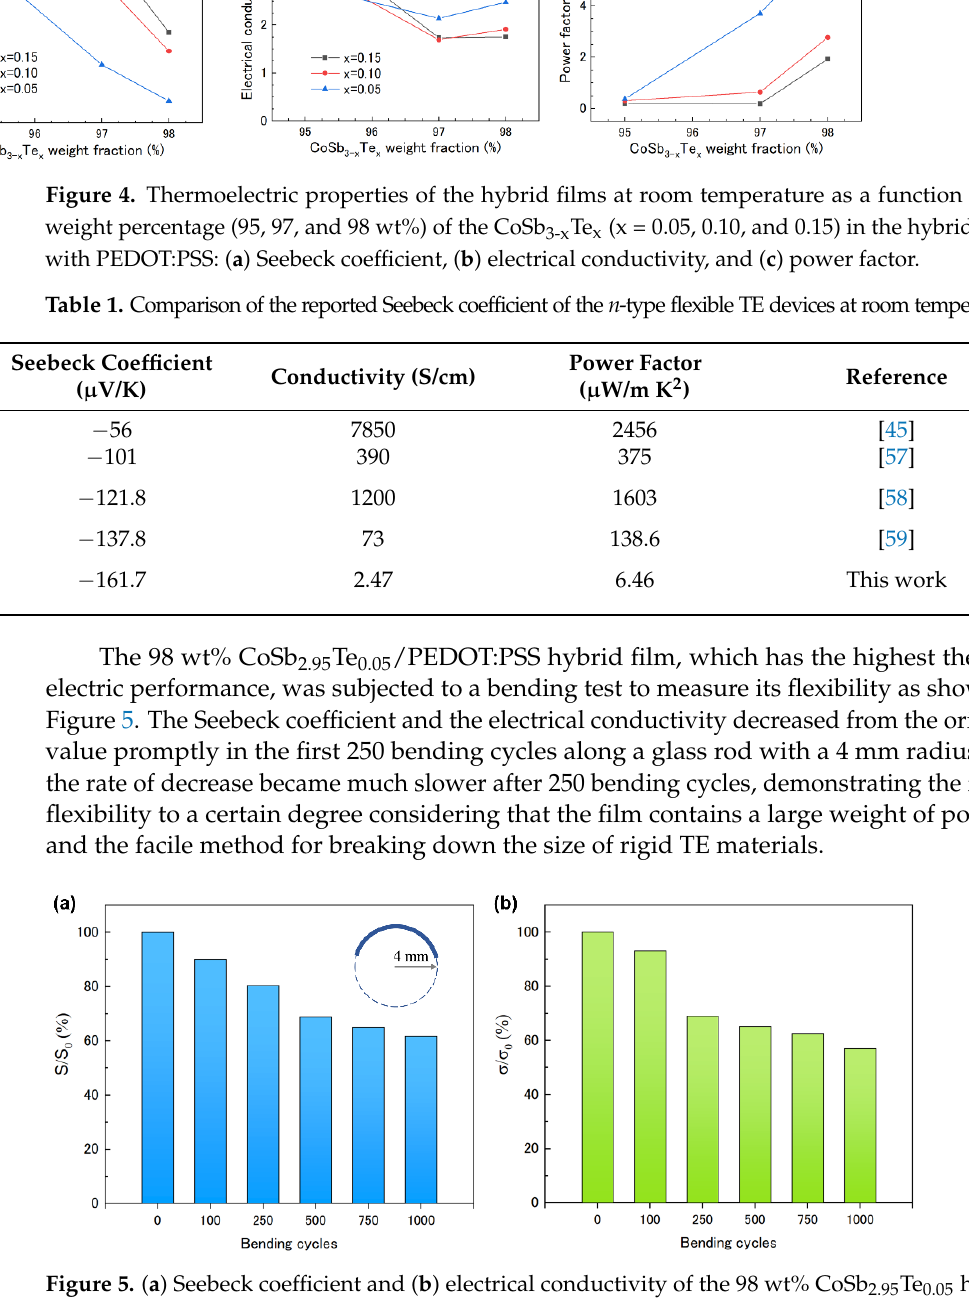
Figure 5. ( a ) Seebeck coefficient and ( b ) electrical conductivity of the 98 wt% CoSb 2.95 Te 0.05 hybrid film as a function of bending